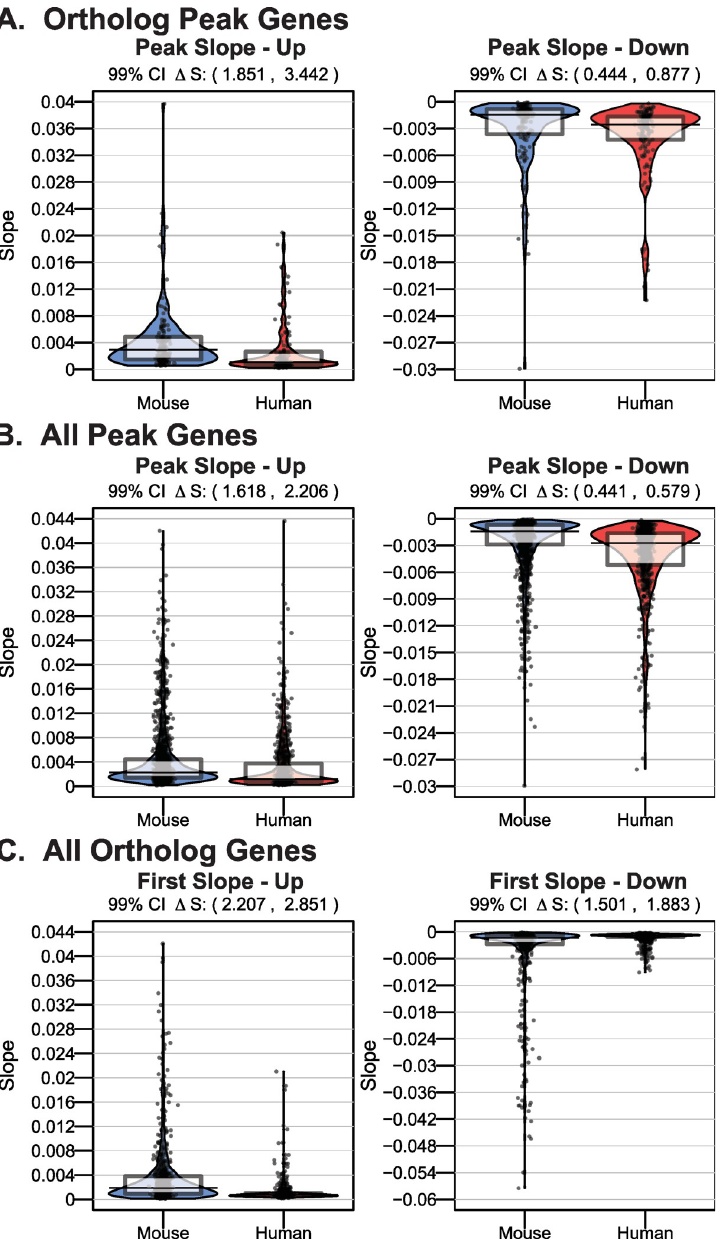
Fig 6. Rate of upregulation of gene expression is faster in mouse compared to human cells. A) For orthologs having a peak in both mouse and human cells, the slopes of the up trend (left) and down trends (right) of the peak are shown as smoothed densities (bean plots) with overlaid raw data, the median, and a box representing the interquartile range. B) Similar as (A) for all genes having a peak in either mouse or human cells. C) For all orthologs having an immediate up trend, the slope of the first breakpoint is shown in a smoothed density plot (left). For genes having an immediate down trend, the slope of the first breakpoint is shown